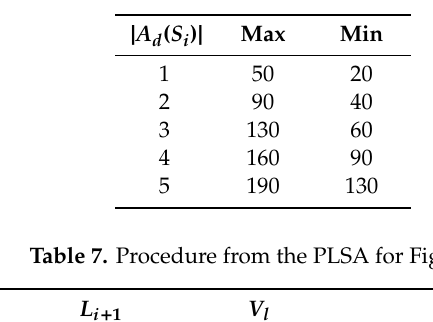
Table 6. Range of c for the distinct number of failed arcs from Table 1.